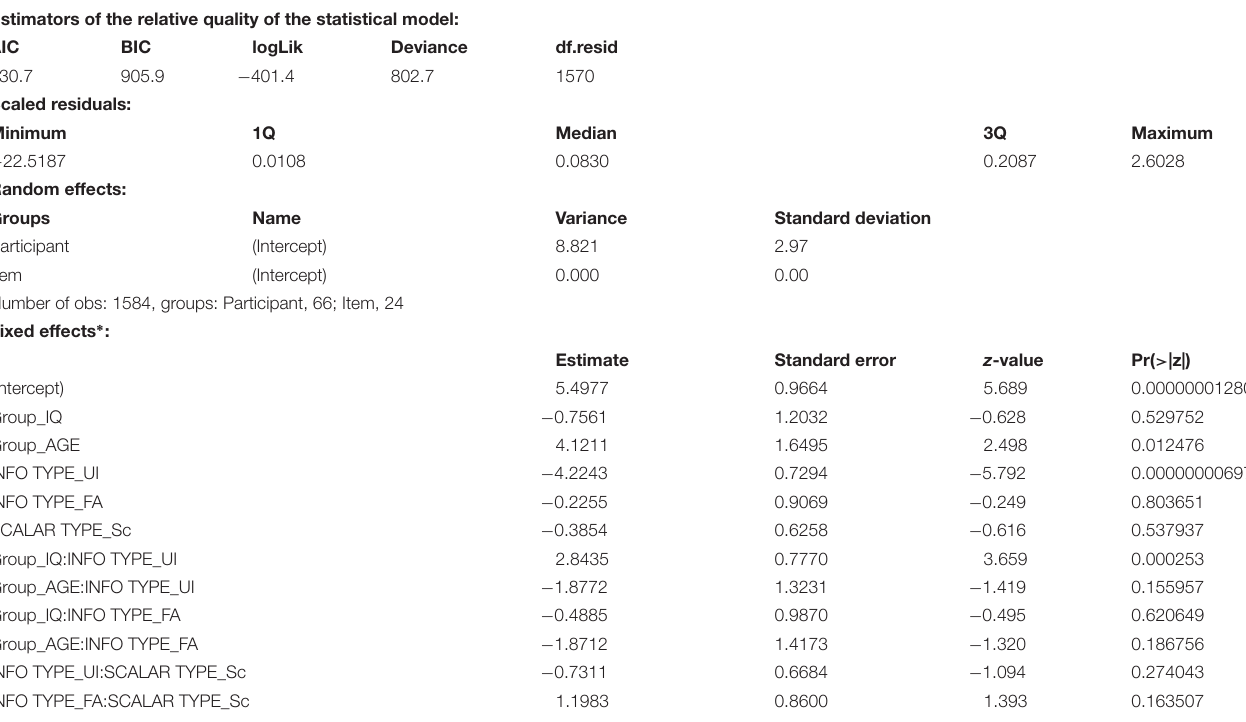
TABLE 3 | A complete description of the final model for Experiment 1: Group ∗ Informativeness Type + Informativeness Type ∗ Scalar Type + (1| Participant) + (1| Item). Estimators of the relative quality of the statistical